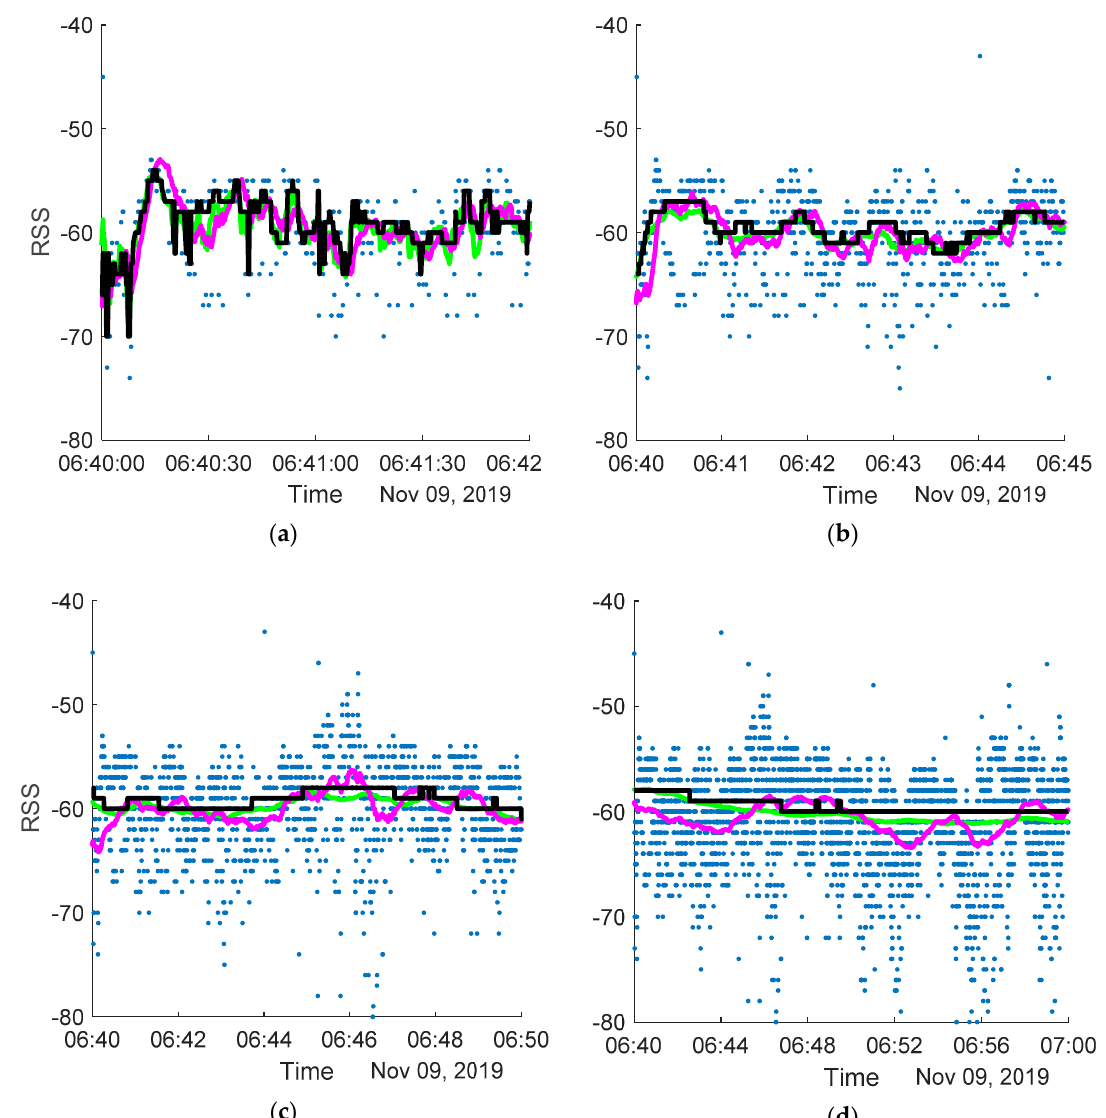
Figure 10. Filtering the RSS using different filters (green—mean filter, black—median filter, purple—Kalman filter) with different parameters: WS = 2 s, q = 10 − 3 in (a), WS = 10 s, q = 10 − 5 in (b), WS = 60 s, q = 10 − 7 in (c) and WS = 300 s, q = 10 − 9 in (d).